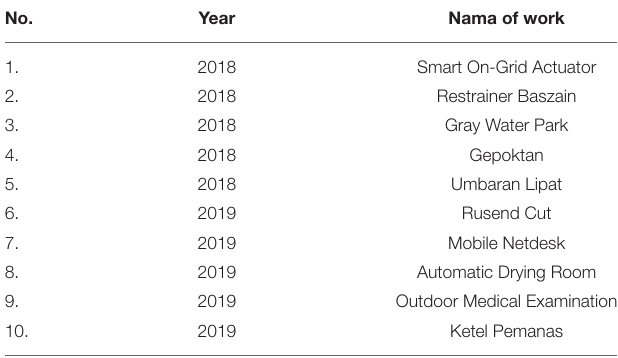
TABLE 3 | Works upgraded to prototype.